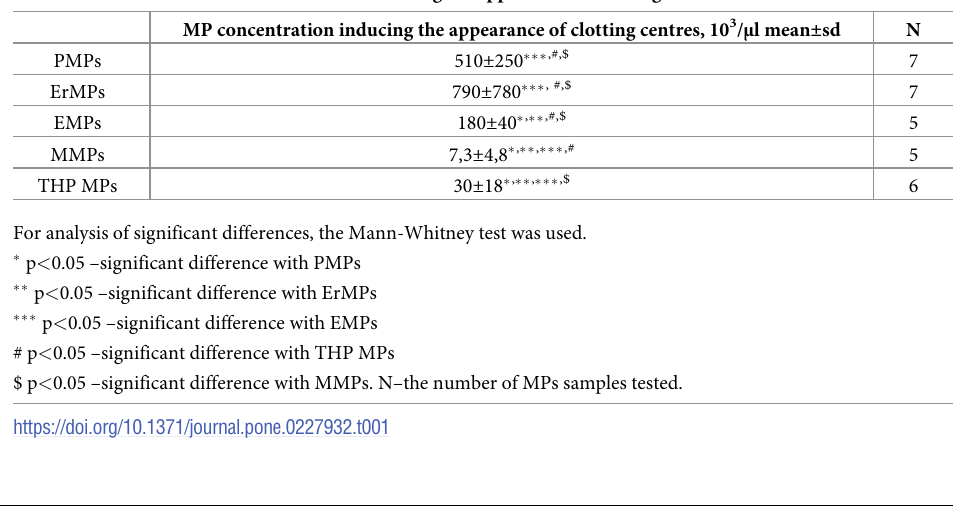
Fig 3. Photos of growing clot and typical patterns of spontaneous clotting induced by MPs of different origins. As MPs of different origins induce spontaneous clotting at 100-fold different concentrations, the photos represented at arbitrary concentrations at which the patterns of clotting centre appearance were well distinguished within 60 min. The MPs concentrations in assays in photos were as follows: PMPs, 627 � 10 3 1/ μ l; ErMPs, 500 � 10 3 1/ μ l; EMPs, 480 � 10 3 1/ μ l; THP MPs, 132 � 10 3 1/ μ l; and MMPs, 132 � 10 3 1/ μ l.